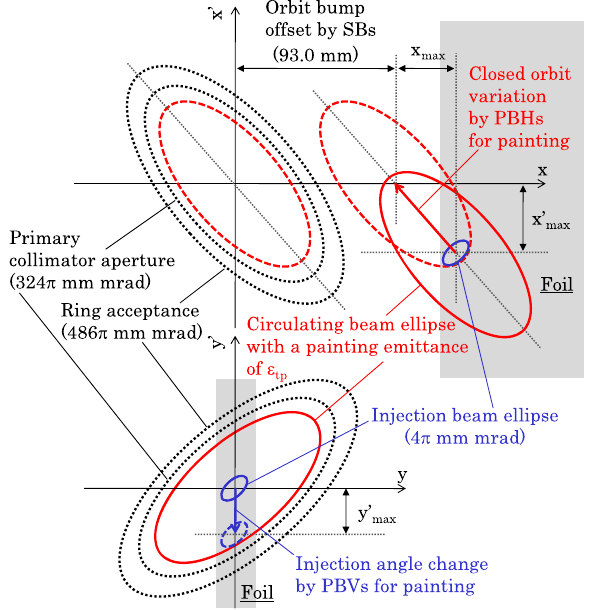
FIG. 4. Schematic diagram of transverse injection painting, where the upper one corresponds to the horizontal plane, and the lower one to the vertical plane.